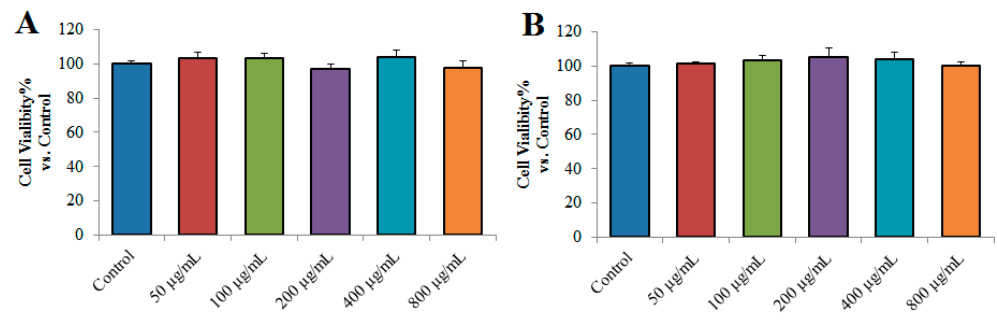
Figure 7. Effects of neutral fraction of total polysaccharides-II (TPN-II) ( A ) and acidic fraction of total polysaccharides -II (TPA-II) ( B ) on cell viability of human airway epithelial cells (NCI-H292).